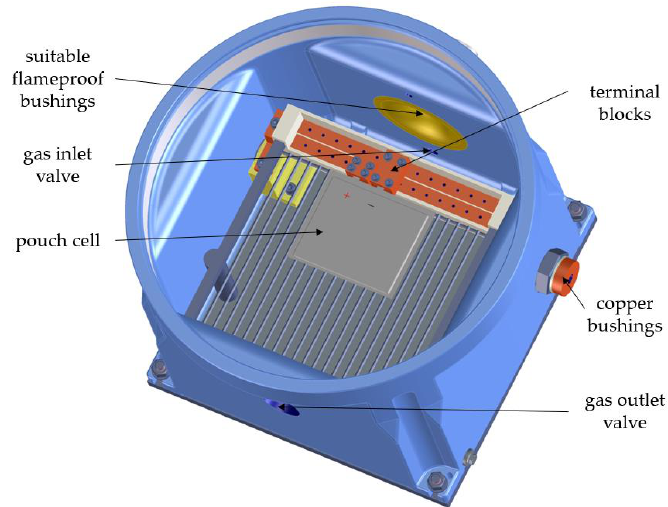
Figure 11. Flameproof enclosure for conducting electrical thermal tests.